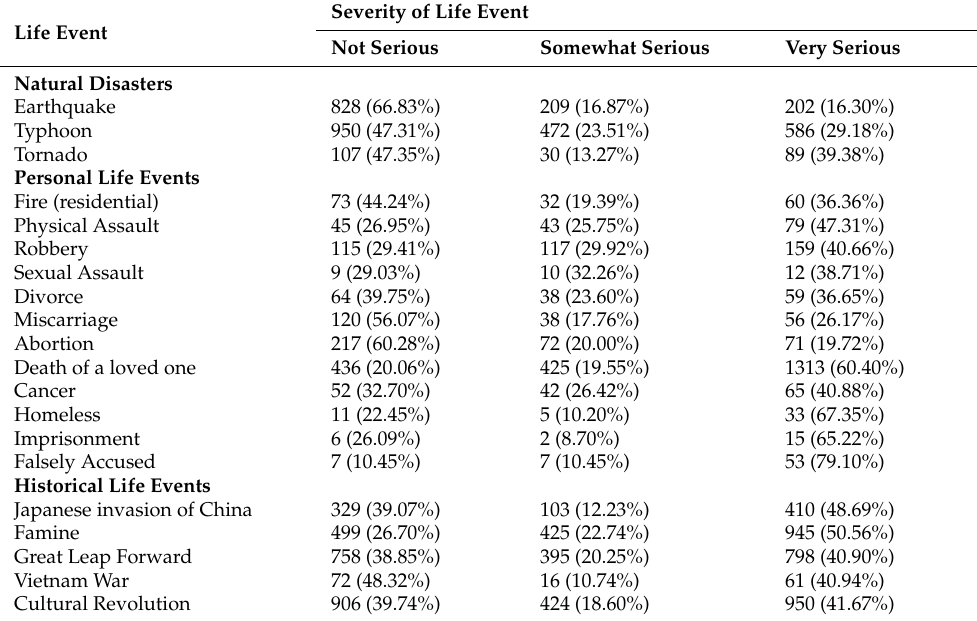
Table 3. Severity of life events ( N =